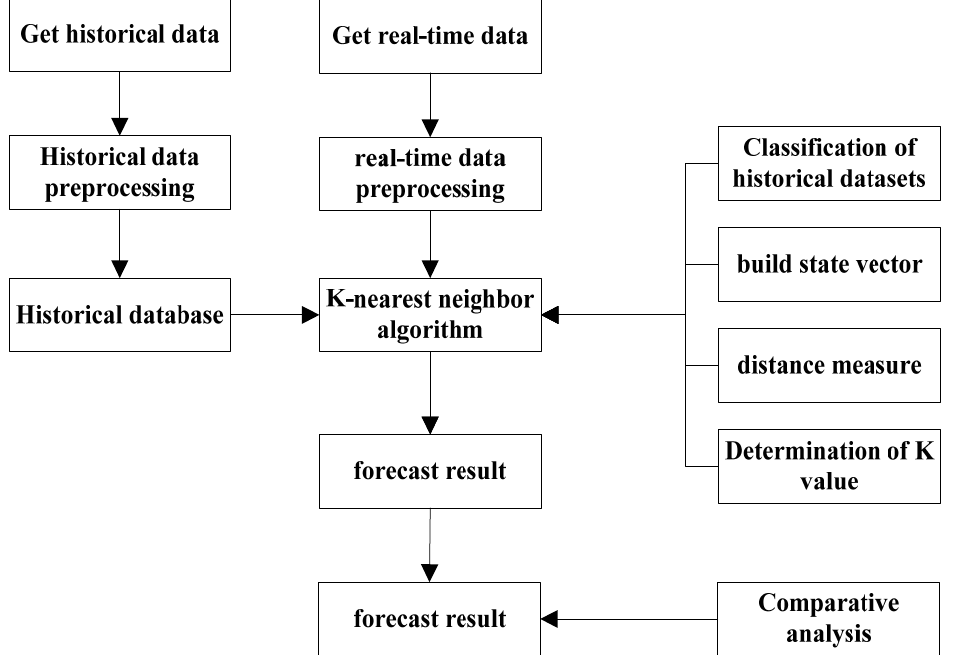
Figure 1. Basic flow chart of the K-nearest neighbor algorithm.